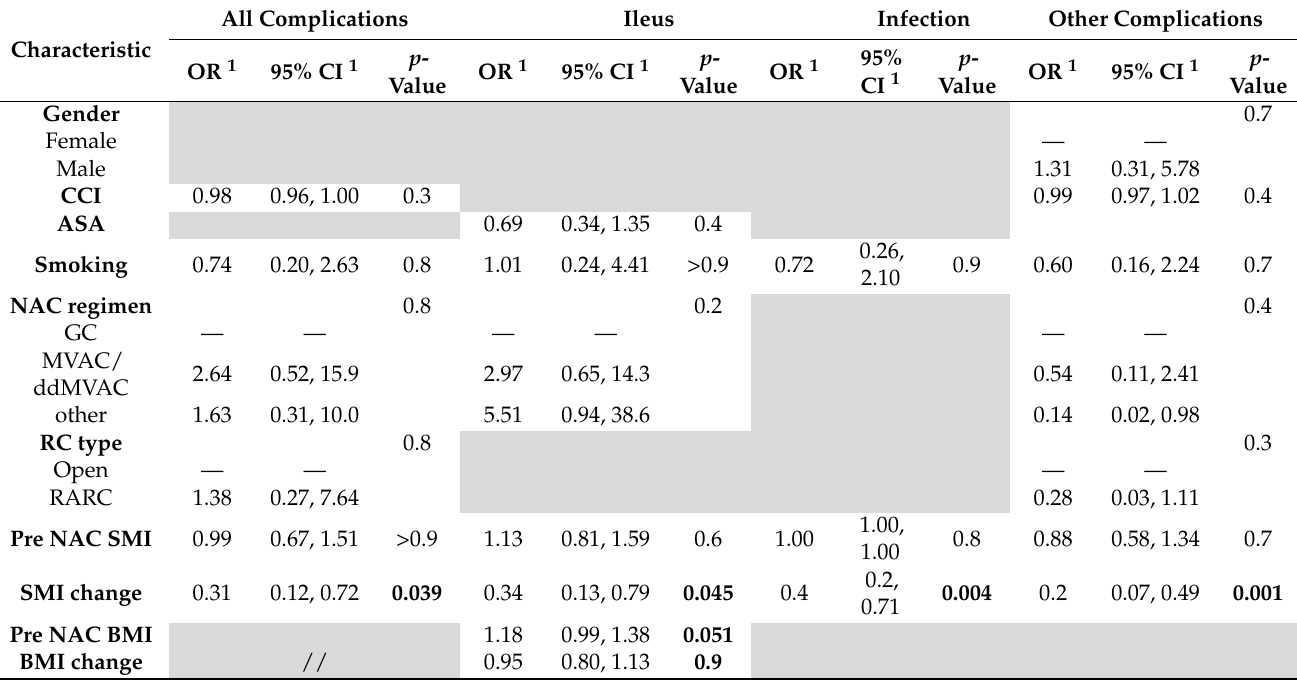
Table 5. Multivariable analysis of different